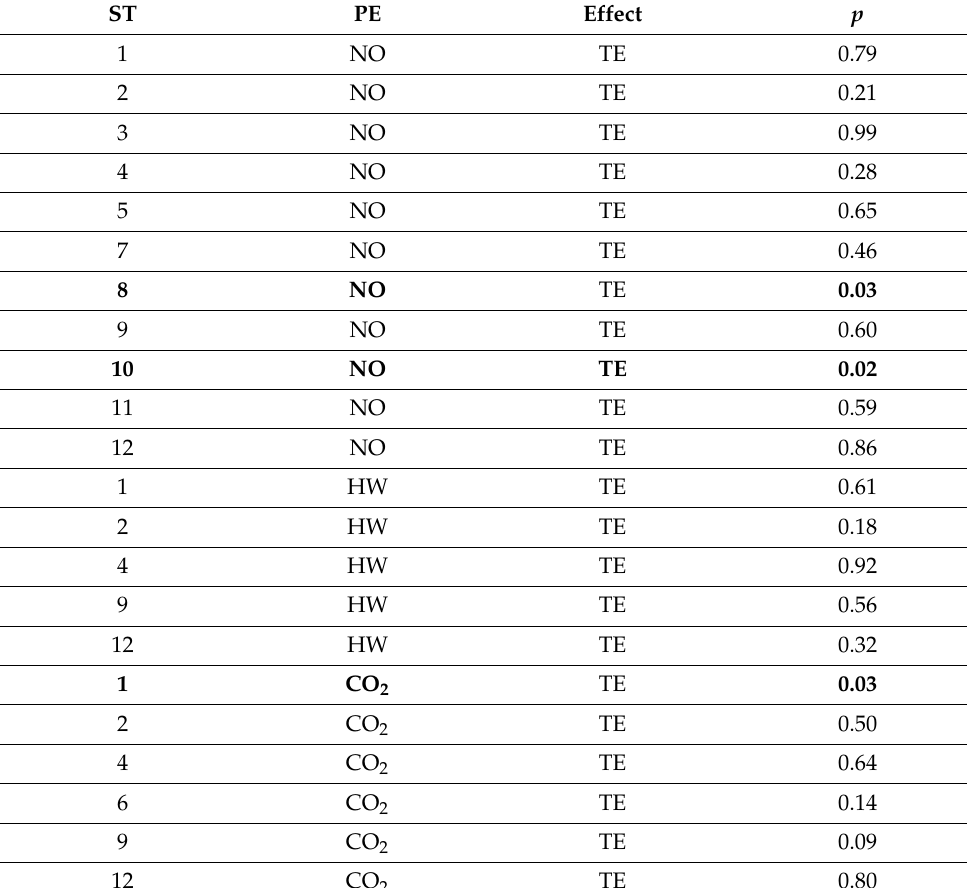
Table 7. Storage temperature effect—one-way ANOVA